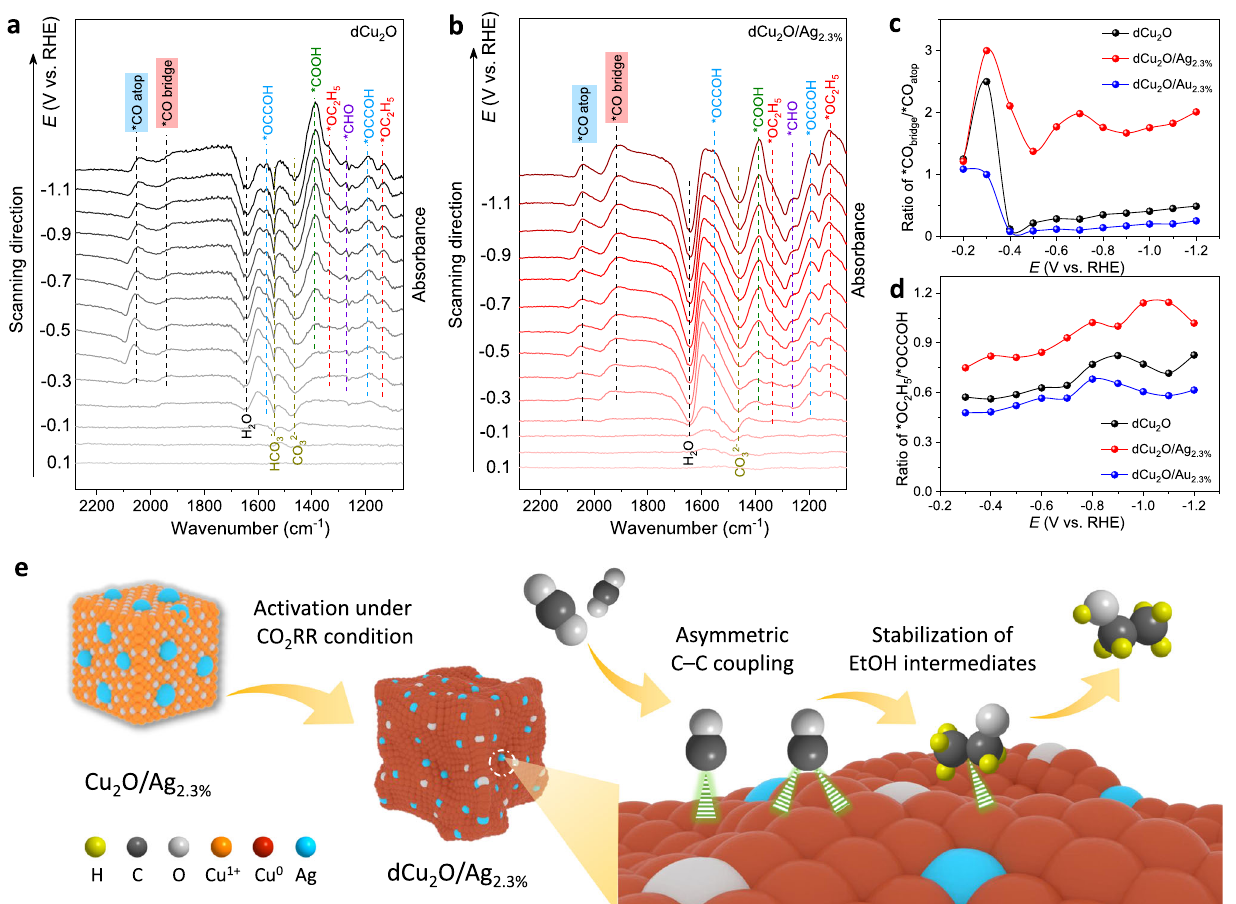
Fig. 5 In situ ATR – IRAS measurement and mechanism for dCu 2 O/Ag 2.3% . In situ ATR – IRAS obtained during chronopotentiometry in a potential window 0.2 to − 1.2 V RHE for a dCu 2 O, and b dCu 2 O/Ag 2.3% under CO 2 RR. (A reference spectrum obtained at 0.3 V RHE in 1 M KOH is subtracted). Potential dependence of ratio of c * CO bridge / * CO atop and d * OC 2 H 5 / * OCCOH obtained for dCu 2 O, dCu 2 O/Ag 2.3% and dCu 2 O/Au 2.3% . e Schematic for boosted EtOH generation over dCu 2 O/Ag 2.3% . Yellow-color, gray, white, orange, red, and azure spheres in the model represent H, C, O, Cu 1 + , Cu 0 , and Ag atoms,